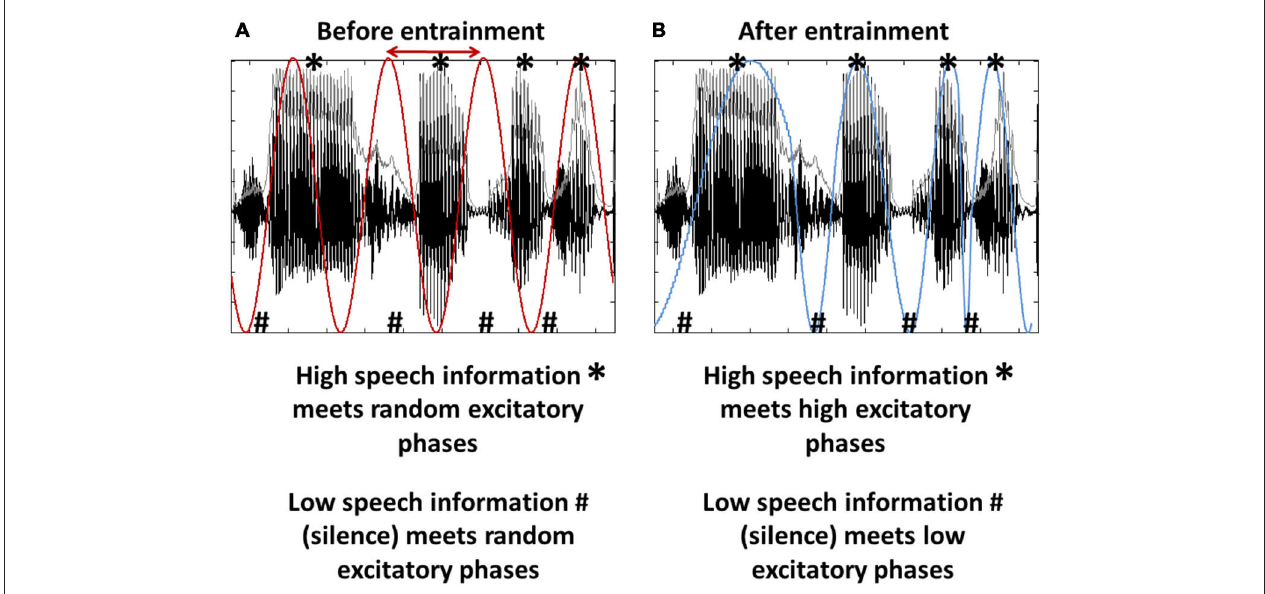
FIGURE 1 | Entrainment as a tool for input gating. (A) Brain oscillations (red) are unrelated to the stimulus input, here a segment of speech sound. Note that both oscillation and speech sound are rhythmic ( ∼ 4 Hz) and that the speech input consists of phases of high ( ∗ ) and low (#) informational content. Both phase and frequency (the latter to a certain extent; Ghitza, 2013, 2014) of the oscillations can be adjusted to match the input rhythm (red arrow), a phenomenon called phase entrainment. (B) Phase entrainment results in an alignment of the oscillation’s high and low excitability phases (blue) with the input’s high and low informational content. It can thus be used as a tool for input